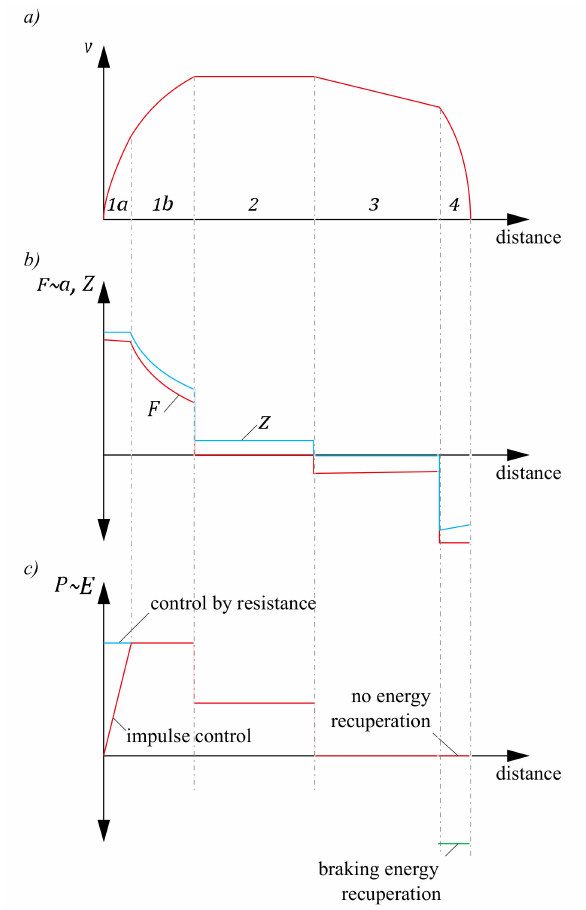
Figure 2. Four train running modes: 1a—starting (according to the curve of constant acceleration), 1b— acceleration (according to the course of the hyperbola of constant power), 2—running at a constant speed, 3—running from coasting, 4—braking. ( a ) Velocity versus distance graph; ( b ) acceleration and acceleration force (red line) and tractive effort (blue line) versus distance graph; ( c ) power and energy of running train with impulse (red on first movement phase) and resistance (blue) control or (in phase 4) braking energy with recuperation (green) and without recuperation